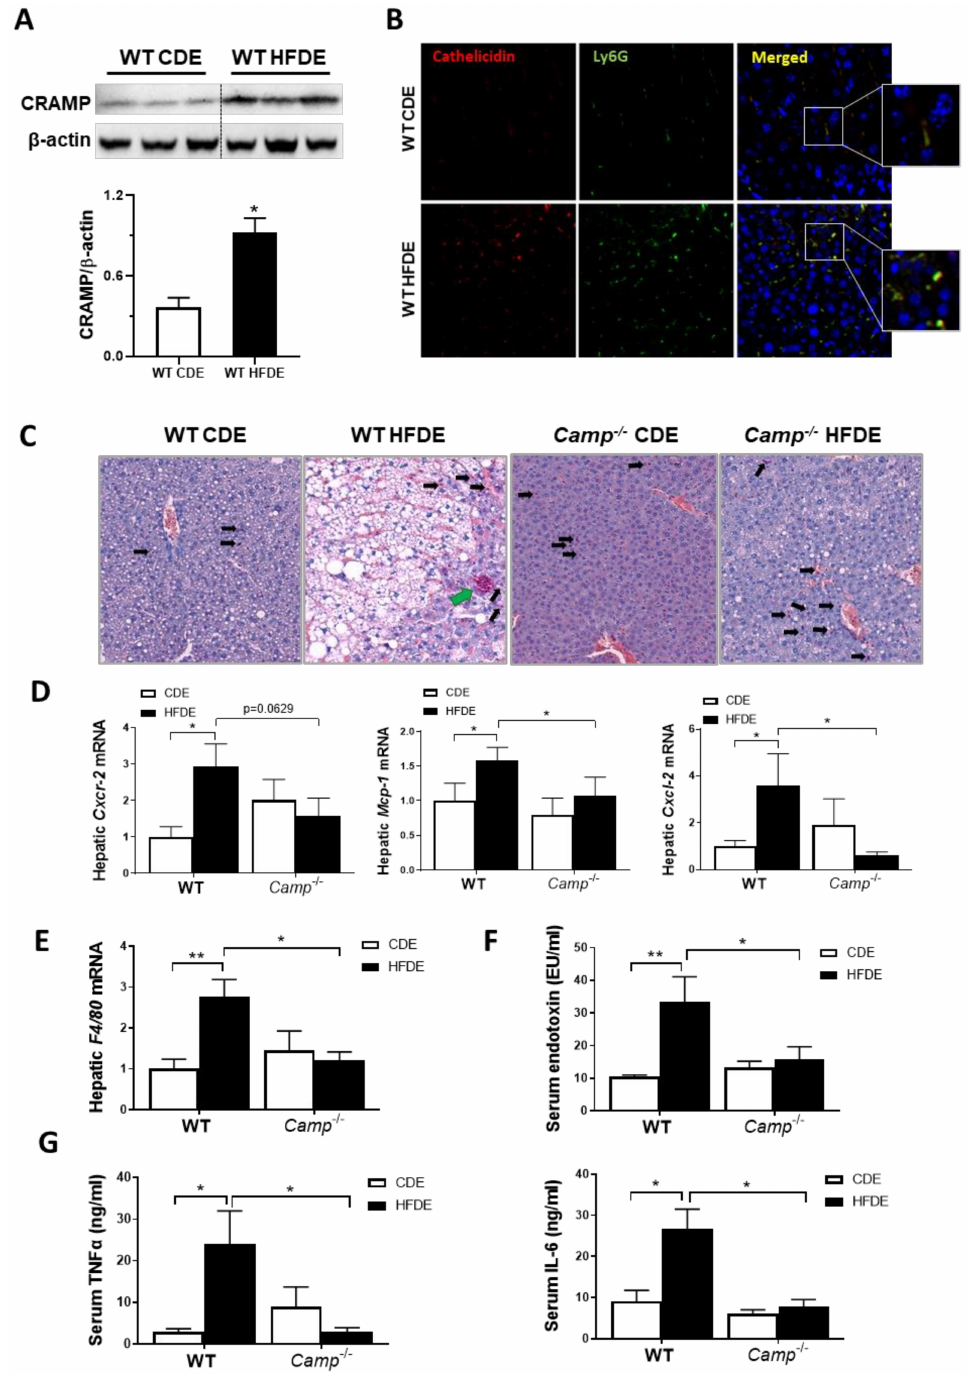
Figure 3. Camp –/– mice had attenuated inflammatory response induced by HFDE treatment in the liver. ( A ) Representative immunoblots (upper panel) and quantification (lower panel) of CRAMP protein in whole liver lysates of WT mice. ( B ) Immunofluorescence (IF) co-staining of Ly6G (Green) and cathelicidin (antibody for mouse CRAMP) (Red) antibodies. Blue: DAPI for nucleus staining. Magnification: 200 × . ( C ) CAE staining of paraffin embedded liver tissue. Infiltrated scattered neutrophils: black arrows; clustered neutrophils: green arrow. Magnification: 100X. ( D ) Hepatic mRNA level of Cxcr2 , Mcp1 and Cxcl2 . ( E ) Hepatic F4/80 mRNA level. ( F ) Serum endotoxin concen- tration. ( G ) Serum levels of TNF α and IL6. Data are expressed in Mean ± SEM (n = 5 mice/group). * p ≤ 0.05, ** p ≤